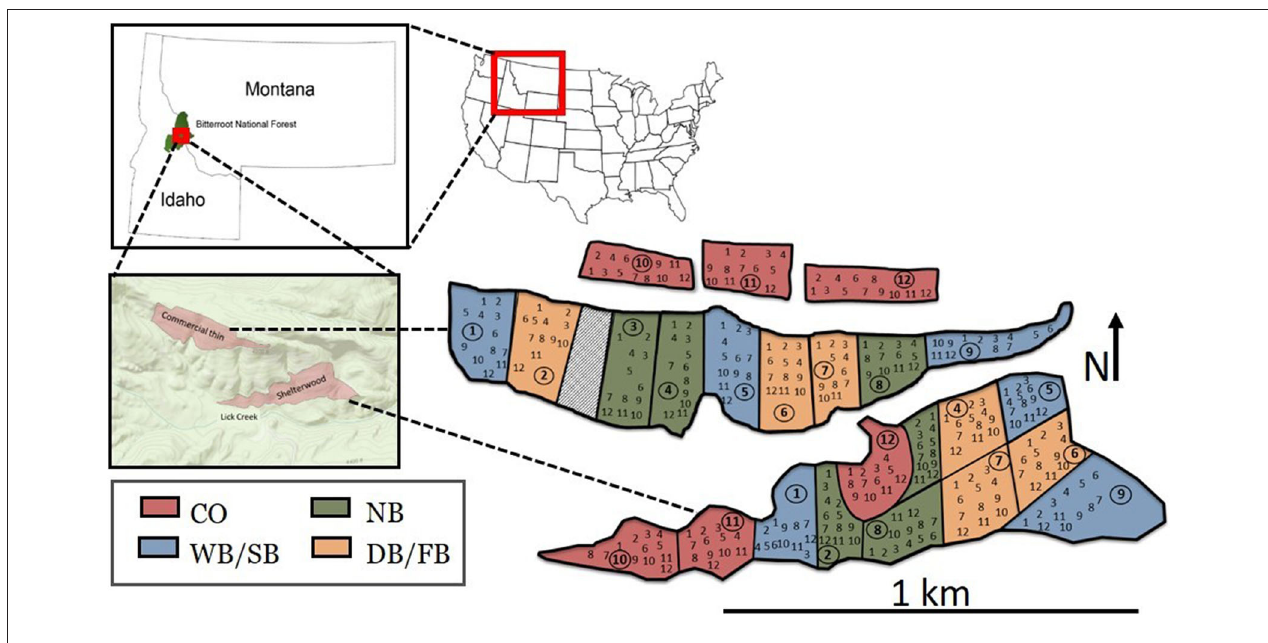
FIGURE 1 | Location of Lick Creek Demonstration/Research Forest and the Thinning and Retention Shelterwood studies by treatment and unit on the Bitterroot National Forest in western Montana. Treatments: CO = Control, NB = Cut, No Burn, SB = Cut + Spring Burn (thinning only), FB = Cut + Fall Burn (thinning only), WB = Cut + Wet Burn (retention shelterwood only), and DB = Cut + Dry Burn (retention shelterwood only). Units are 1–2